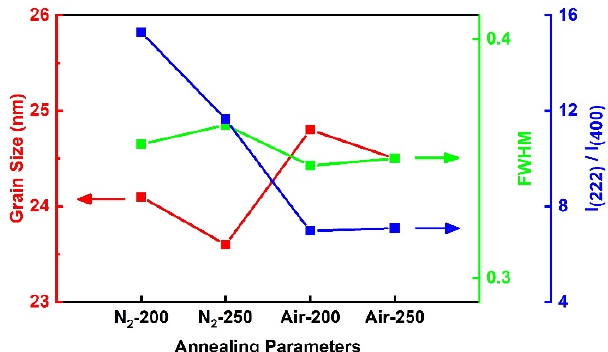
Figure 6. Size of (222)-oriented grains, half-height width of diffraction peaks, and relative intensity of (222)/(400) peaks versus annealing atmosphere.